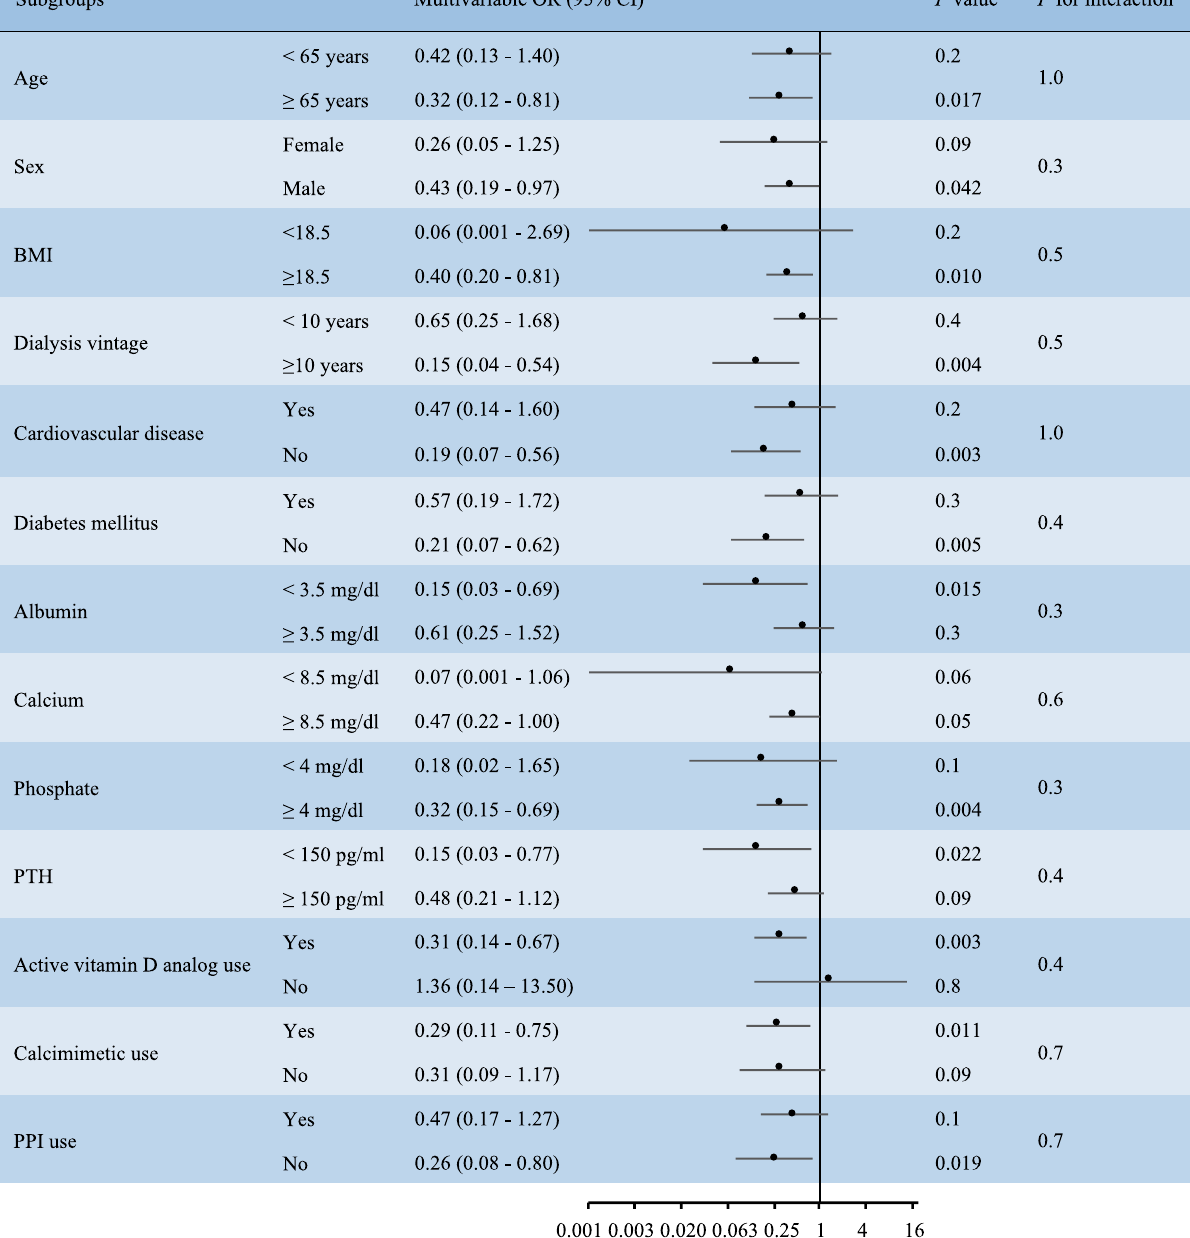
Figure 1. Evaluation of calcium-based phosphate binders’ effects on osteoporosis in various subgroups. Odds ratios (ORs) with the corresponding 95% confidence intervals (95% CIs). P < 0.05 was considered statistically significant. BMI, body mass index; PPI, proton pump inhibitor; PTH, parathyroid